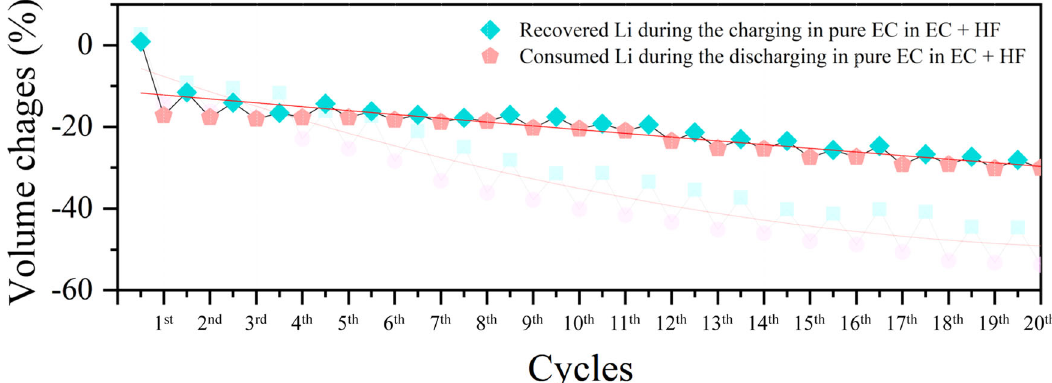
Fig. 7 Mitigated volume changes of lithium metal anode in the EC + HF electrolyte battery system. The transparent line in the fi gure shows the comparative results with pure EC